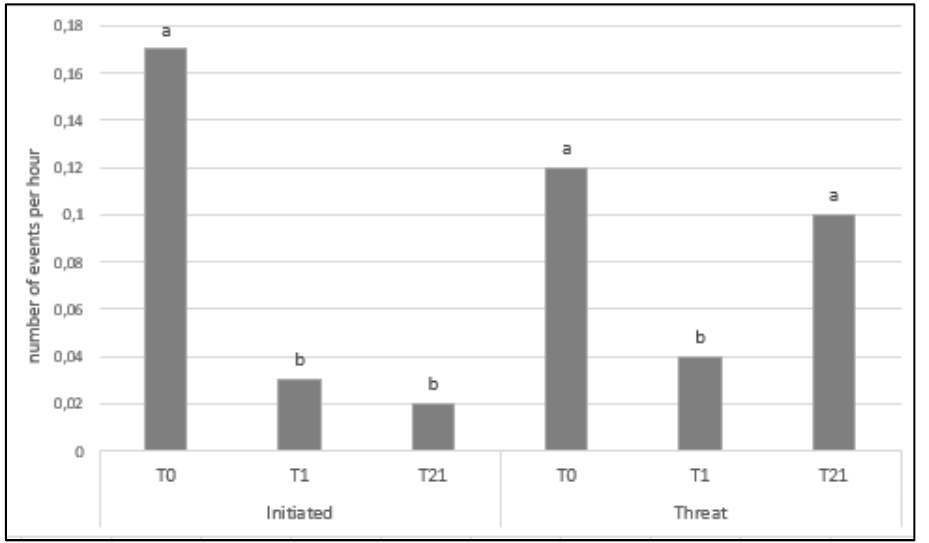
Figure 2. Number of initiated aggressive behaviors and threats per hour in the CONTROL and IMPROVED pens. a, b: Different letters indicates significant differences ( p < 0.05) between treatments.